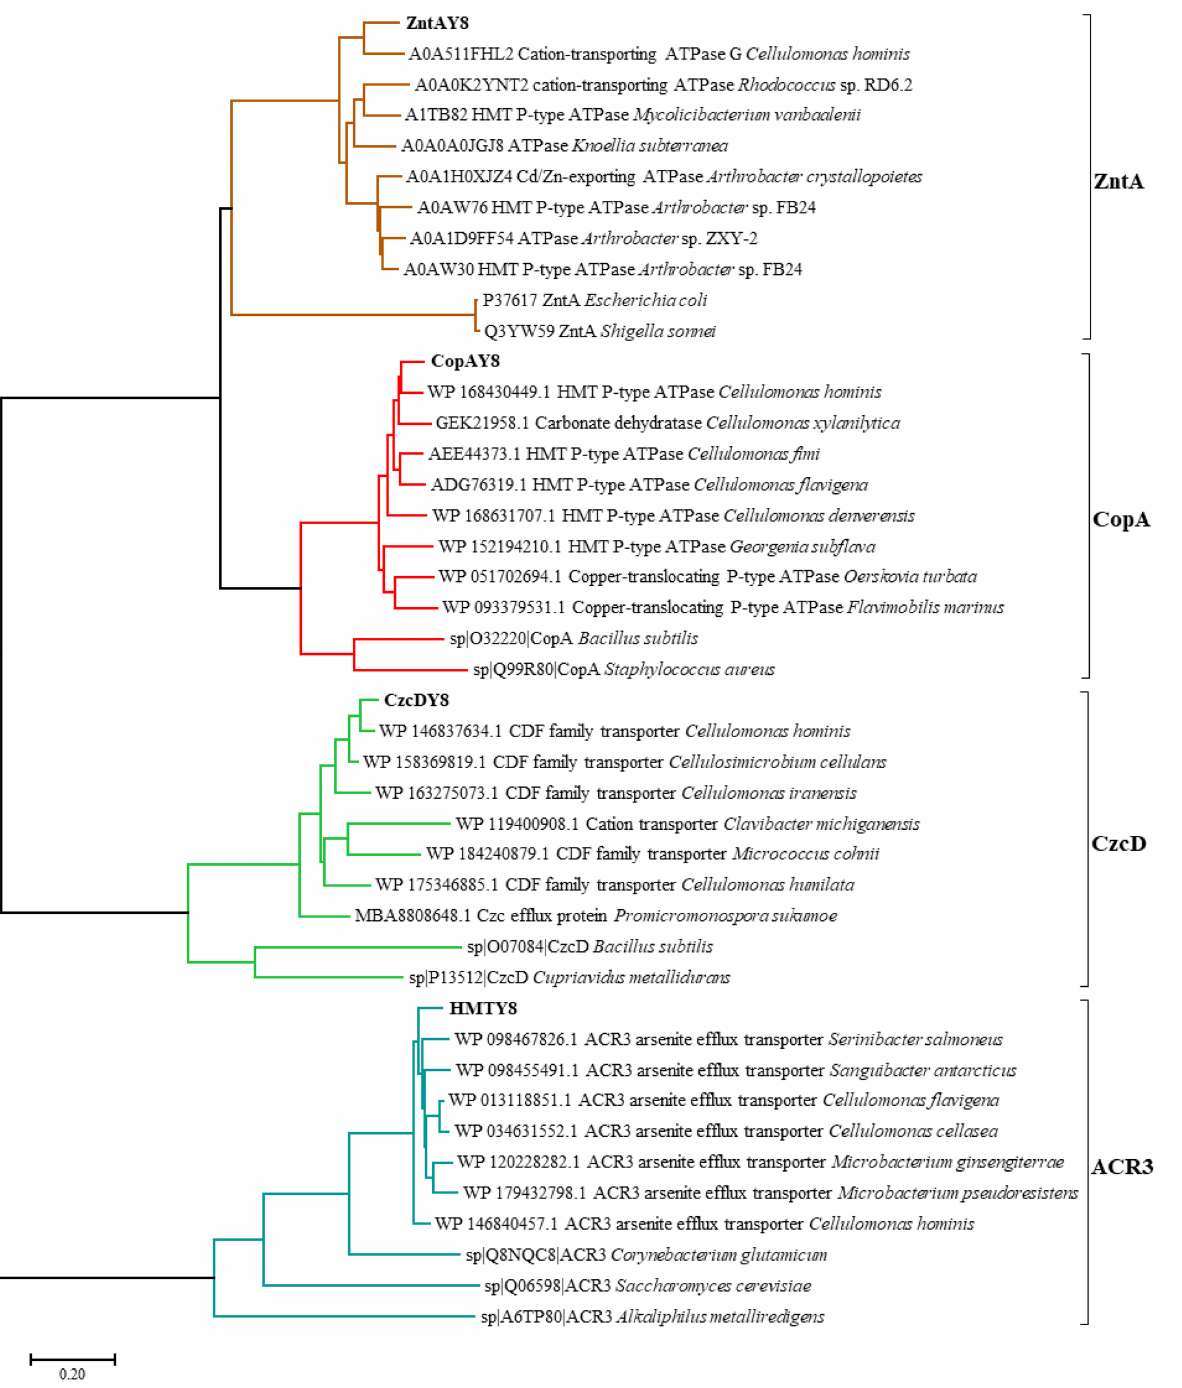
FIGURE 3 | A phylogenetic tree showing the protein sequence similarity of candidate metal resistance genes in strain Y8’s genome and homologs. The tree was constructed using the Maximum Likelihood method within MEGA 7.0 (Kumar et al., 2016). Bootstrap values were estimated from 1,000 replicates. Sequence alignment was performed using ClustalX (Larkin et al.,